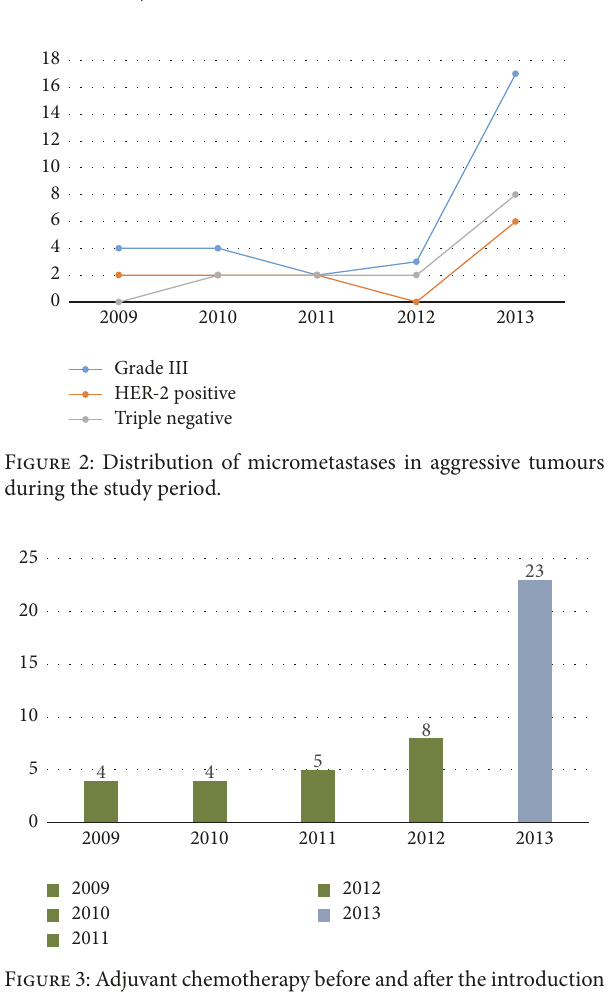
Figure 3: Adjuvant chemotherapy before and after the introduction of OSNA.